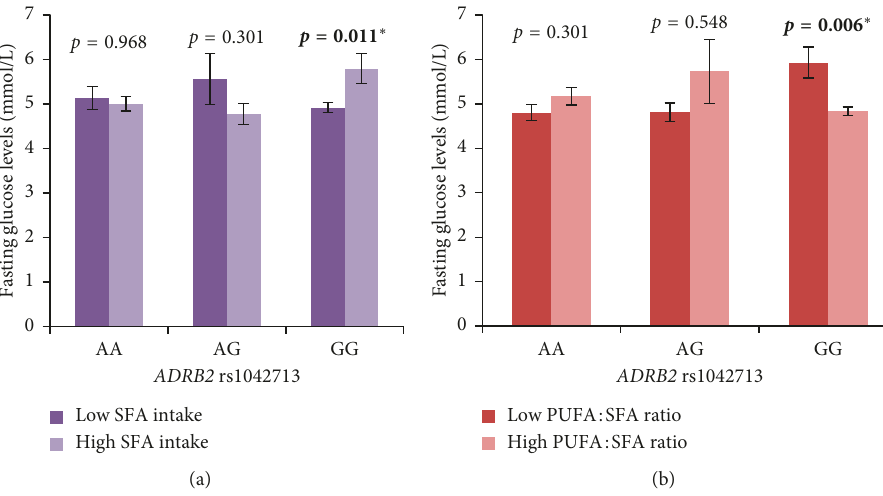
Figure 1: The effect of the interaction between ADRB2 rs1042713 and (a) SFA intake and (b) PUFA : SFA ratio. SFA and PUFA : SFA ratios were dichotomised into two groups by using the median value of 7.3% of TE/day and 0.8/day (for all participants), respectively, for analysis. Gene-diet interaction was evaluated by using the multivariate general linear model after adjusting for age, gender, BMI, physical activity status, smoking status, alcohol consumption, and total energy intake. acid; PUFA: polyunsaturated fatty acid.